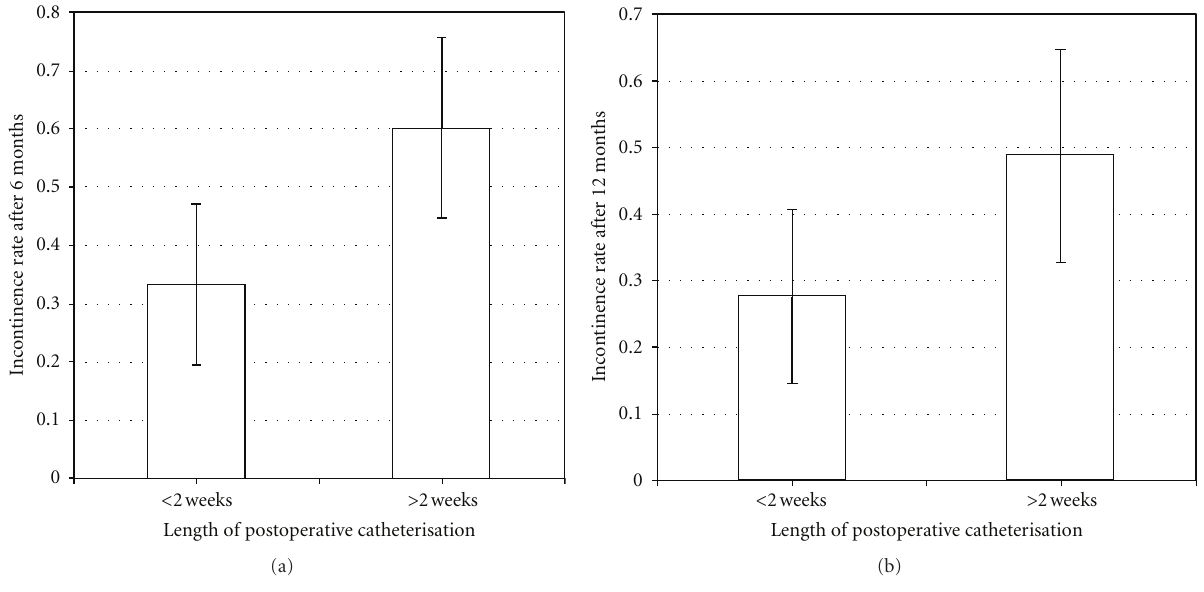
Figure 2: Relationship between time of catheter removal and incontinence rates 6 and 12 months after operation.